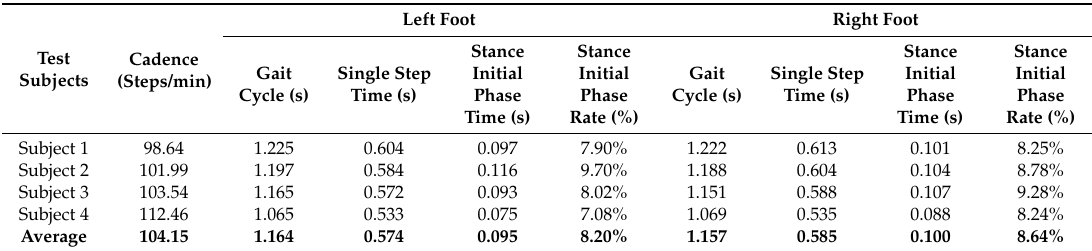
Table 6. Estimation results of gait temporal